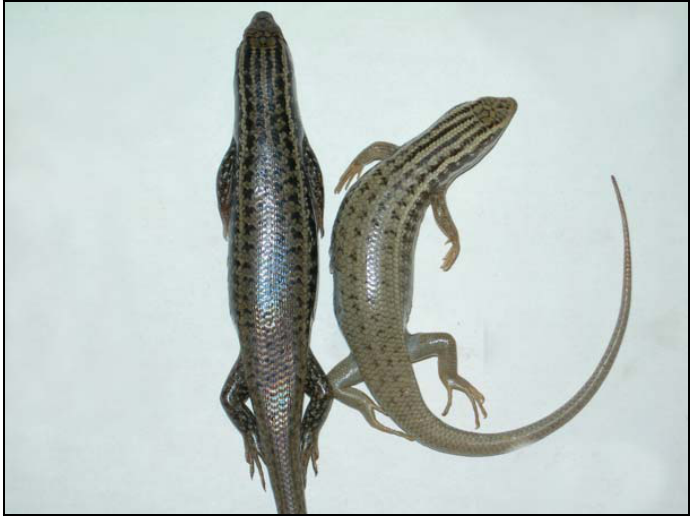
F IG .4.- Comparison of Trachylepis aurata transcaucasica (left) and T. septemtaeniata